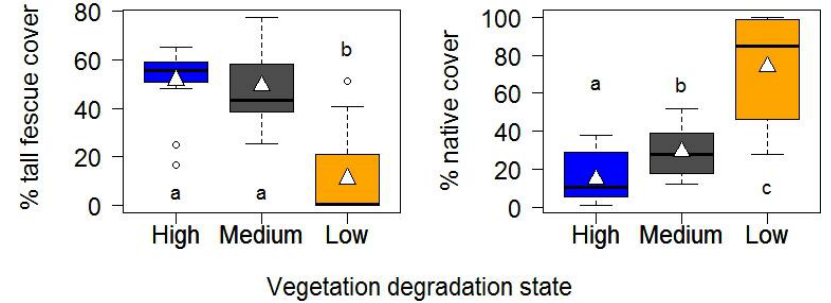
Figure 5. Box plots of six factors associated with degradation plotted by vegetation degradation states. Overlap among states and outliers suggest individual modified Whittaker plots in transition between states. Boxes include the first and third quartiles; horizontal lines denote data median and open triangles denote data mean. Whiskers extend to one interquartile and outliers are denoted as open circles. Letters indicate statistical difference ( p ≤ 0.05) between means in pairwise